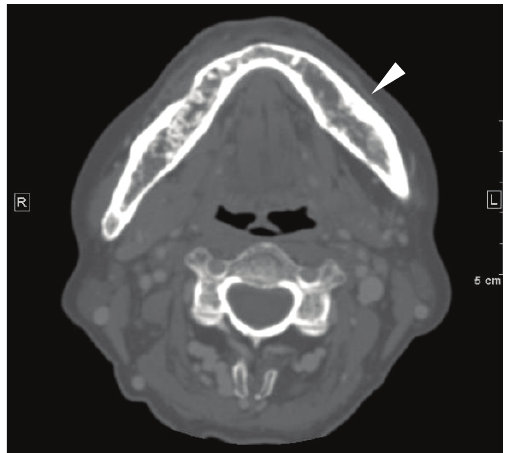
Figure 3: An enhanced CT scan indicated the mixture of acute and chronic osteomyelitis in the left